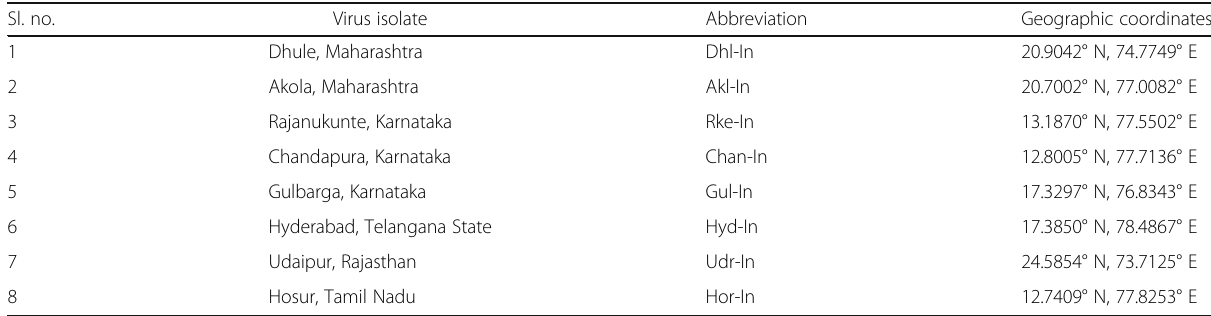
Table 1 Helicoverpa armigera nucleopolyhedrosis virus ( Hear NPV) isolates from various geographical locations in India Sl.